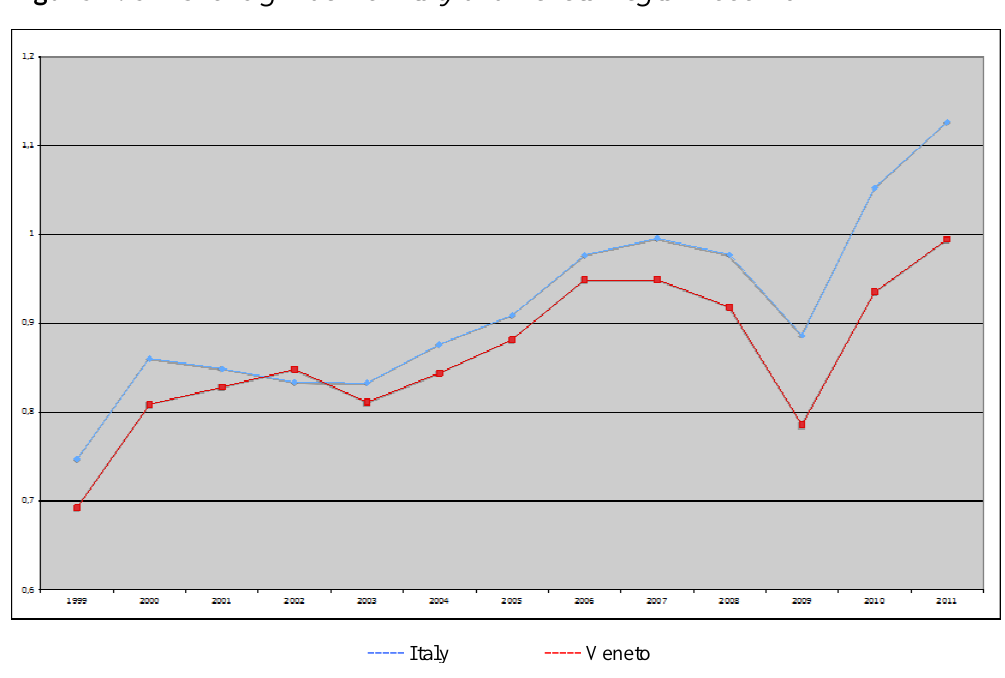
Figure 2: Off-Shoring Index for Italy and Veneto Region